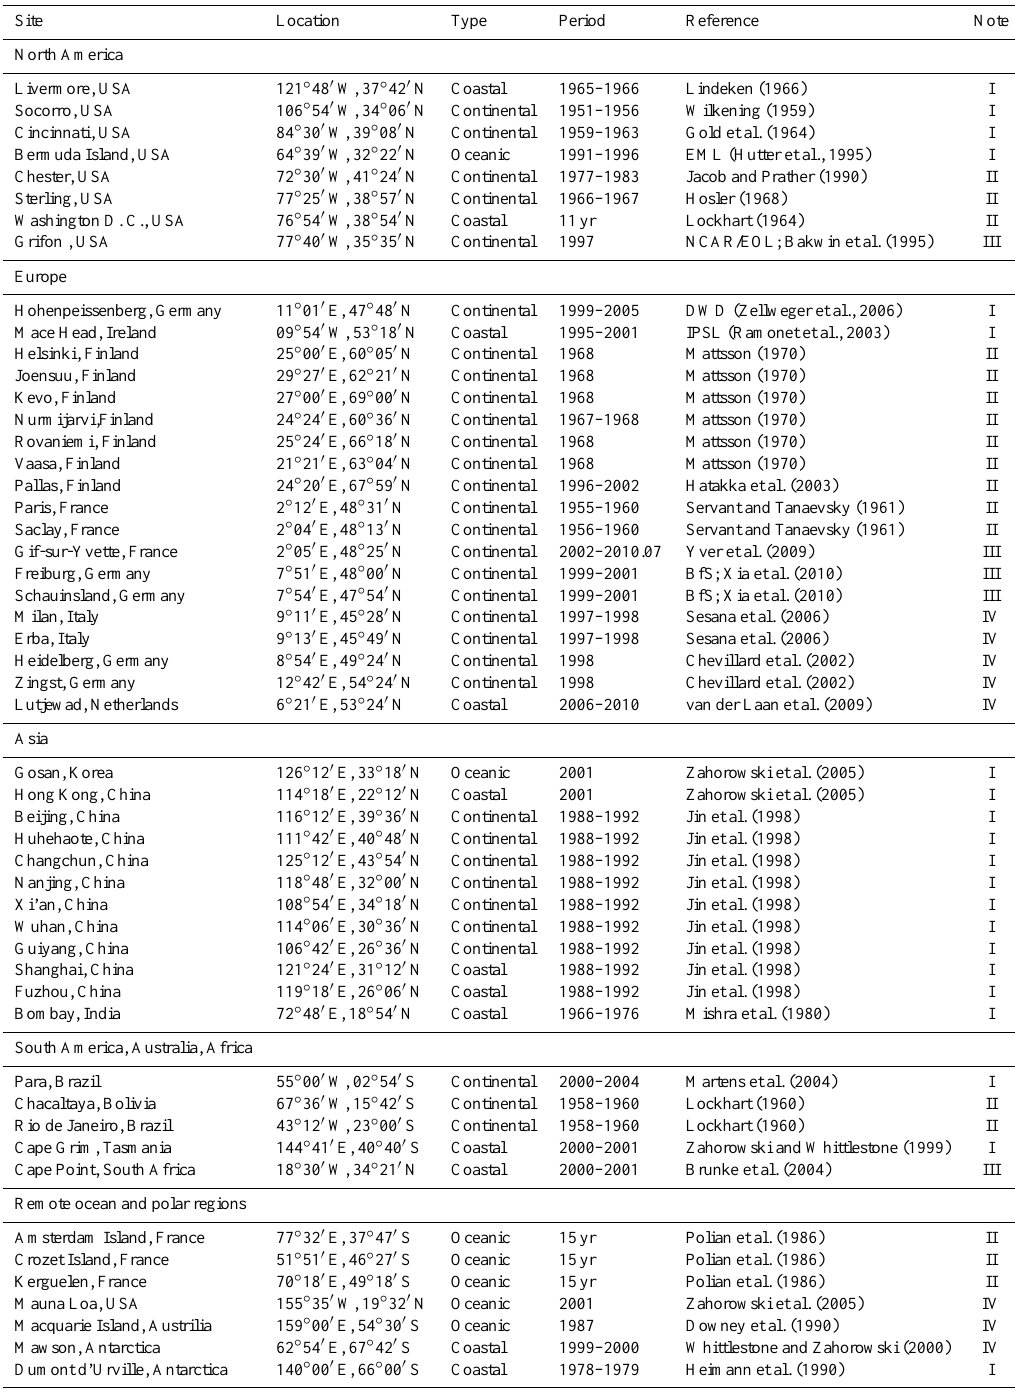
Table 2. Detailed information about the surface radon measurements used in this study. In the “Reference” column, DWD stands for Deutscher Wetterdienst (German Weather Service), BfS for Federal Office for Radiation Protection of Germany, IPSL for Institut Pierre- Simon Laplace, EML for DOE/Environmental Measurements Laboratory, and NCAR/EOL for National Center for Atmospheric Research Earth Observing Laboratory. The right most column categorizes the data source: I: Data already used for model evaluation in Zhang et al. (2008); II: Data of the period 1955–1987 compiled by J. Feichter; III: New measurements from observers; IV: New data from recent publications. Location of these site are also shown in Fig.